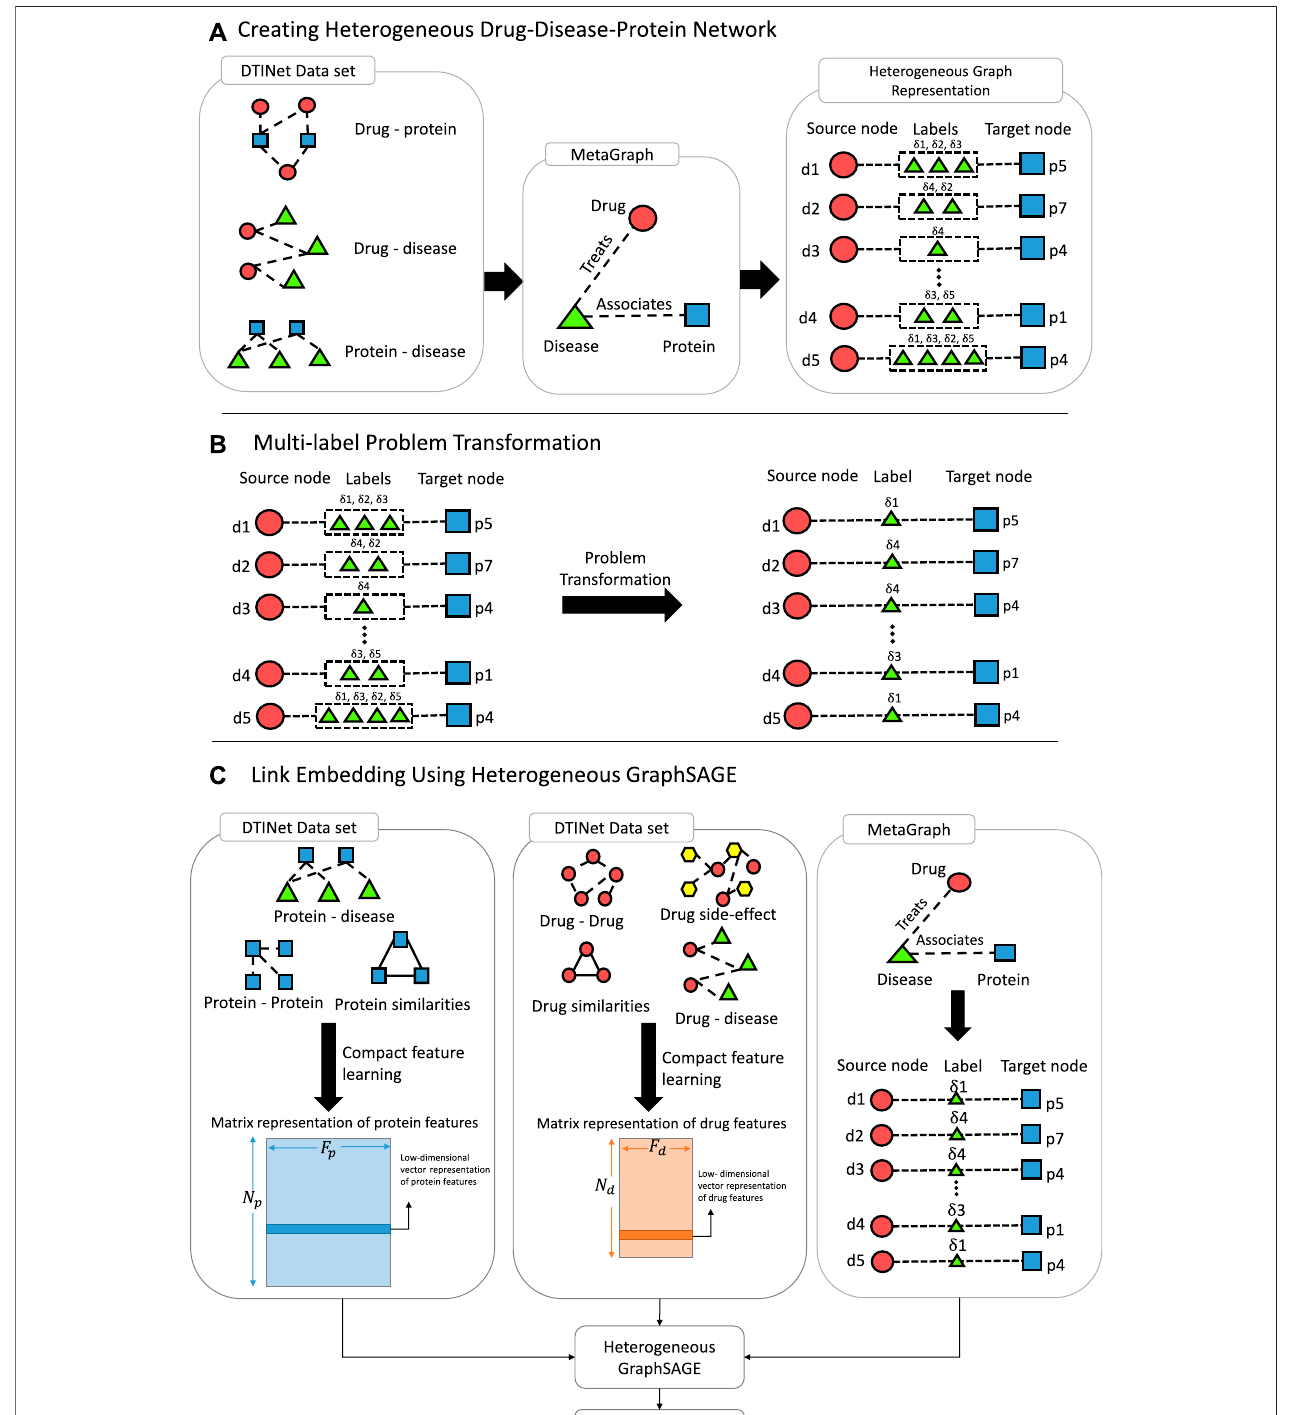
Frontiers in Pharmacology |